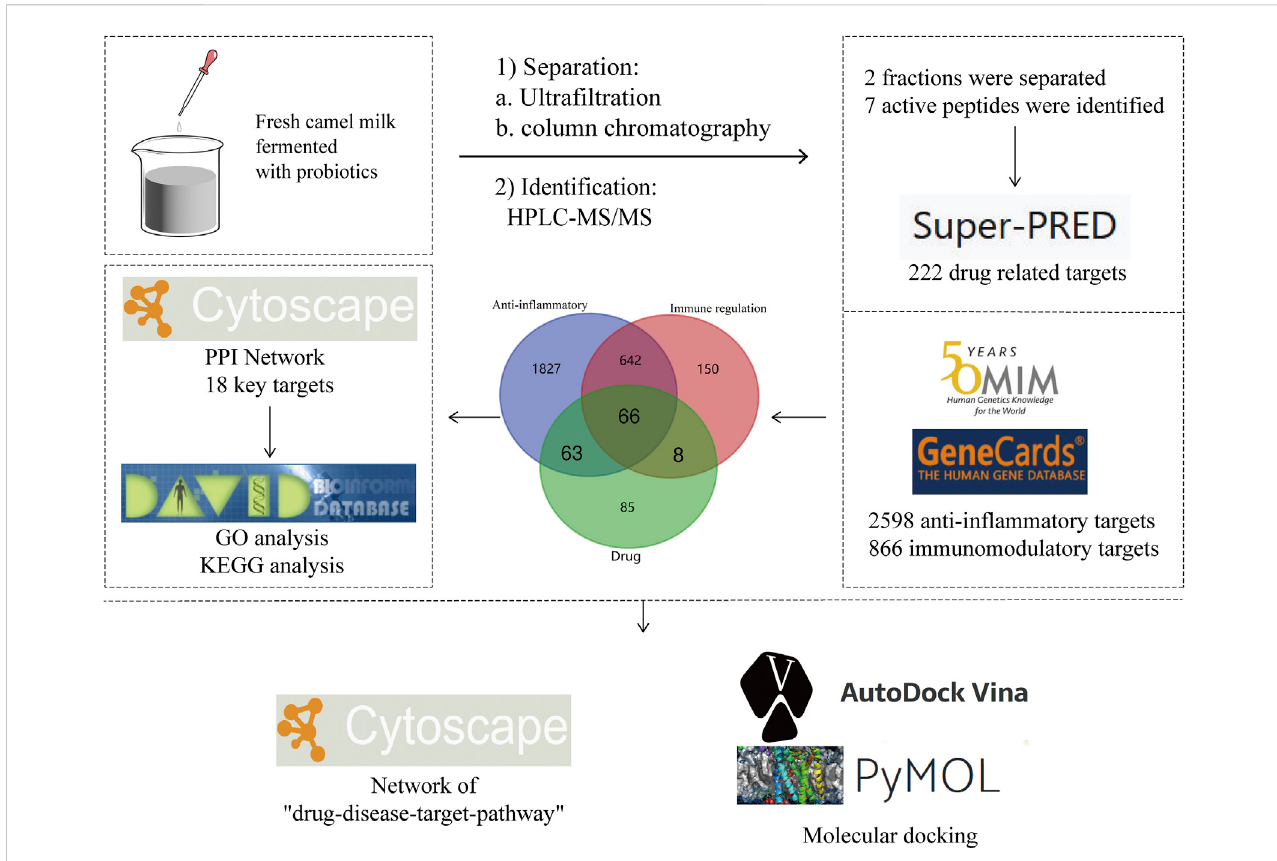
FIGURE 1 The procedure for this